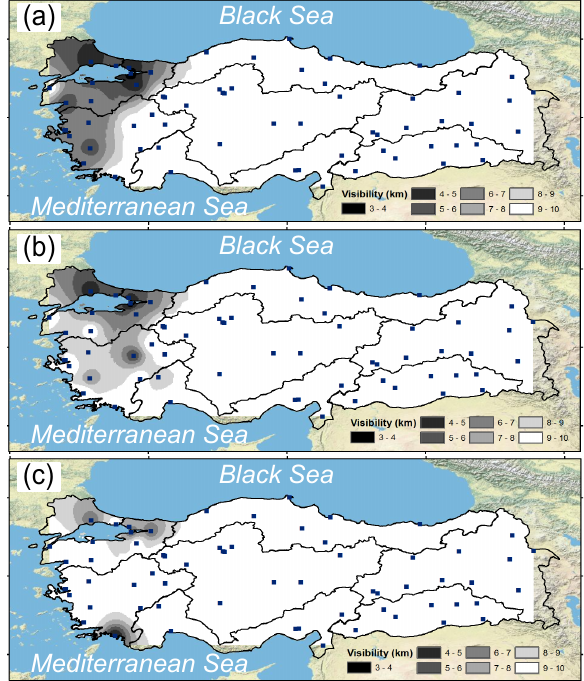
Figure 5. ( a ) Spatial distribution of the horizontal visibility conditions of the METAR observations belonging to 64 airports at 06:00 UTC of 24 March. ( b ) Same as ( a ) but for 09:00 UTC. ( c ) same as ( a ) but for 12:00 UTC.